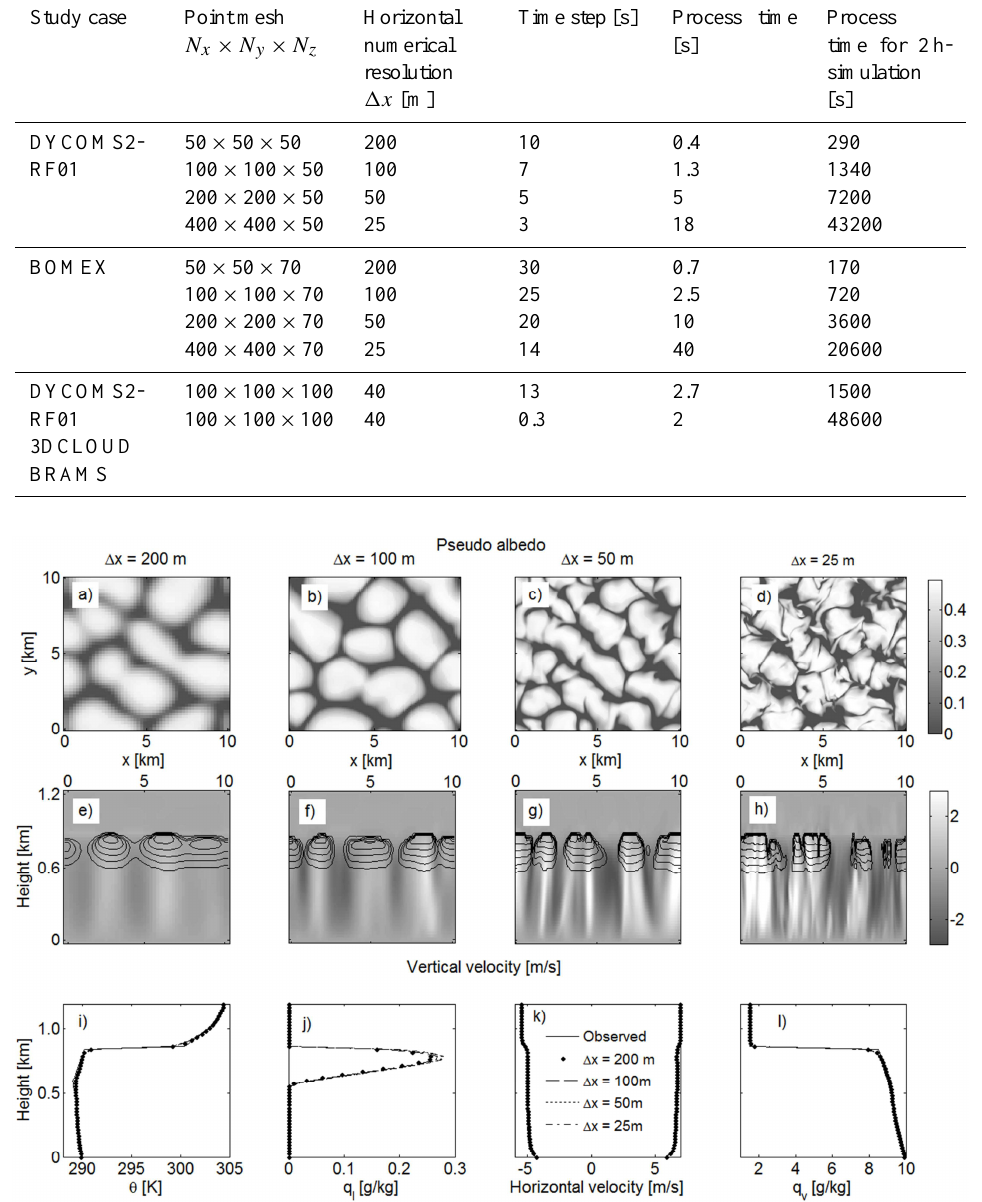
Table 1. Time step, process time for one time step and process time for 2h-simulation with 3DCLOUD model, as a function of the numerical resolution. DYCOMS2-RF01 and BOMEX cases are presented. A comparison between 3DCLOUD and BRAMS LES computation time for a specific DYCOMS2-RF01 case is added. 3DCLOUD (Matlab code) runs on a personal computer with Intel Xeon E5520 (2.26GHz) and BRAMS (Fortran code) runs on a PowerEdge R720 with Intel Xeon E5-2670 (2.60GHz), both of them having a single-processor configuration.